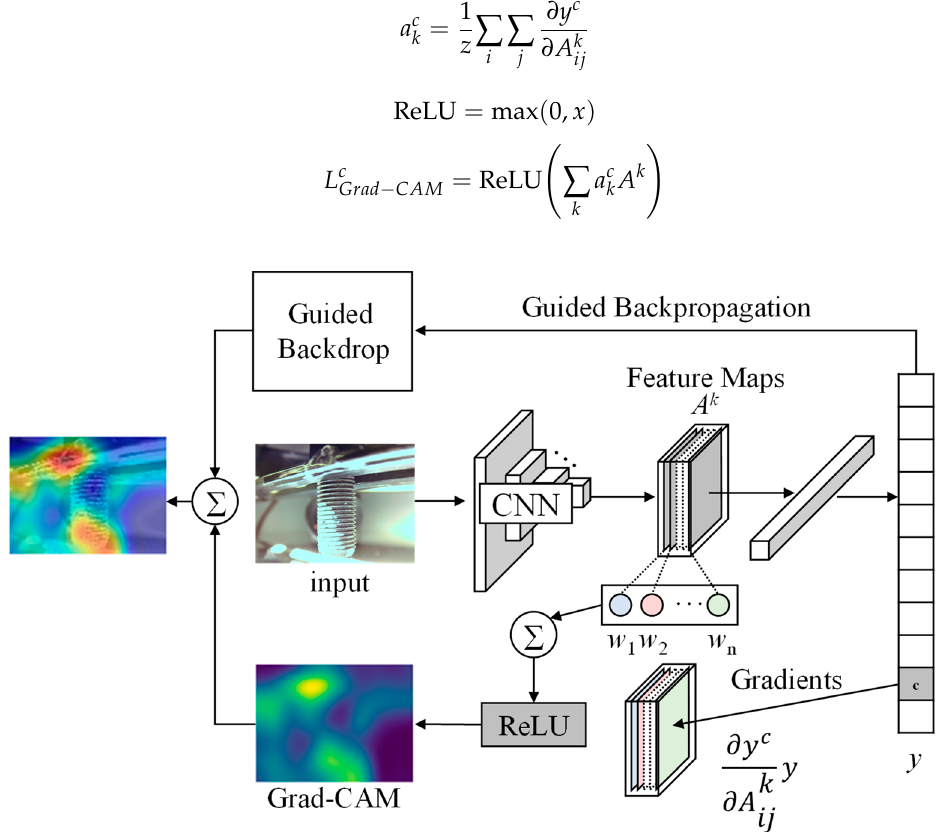
Figure 6. Visualization by Grad-CAM and CNN.